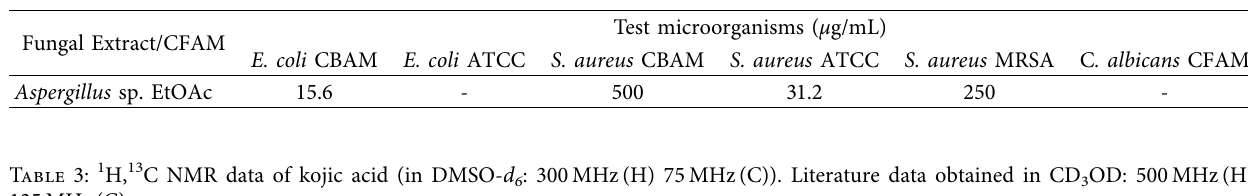
6 : 300MHz (H) 75 MHz(C)). Literature data obtained in CD 3 OD: 500MHz (H)